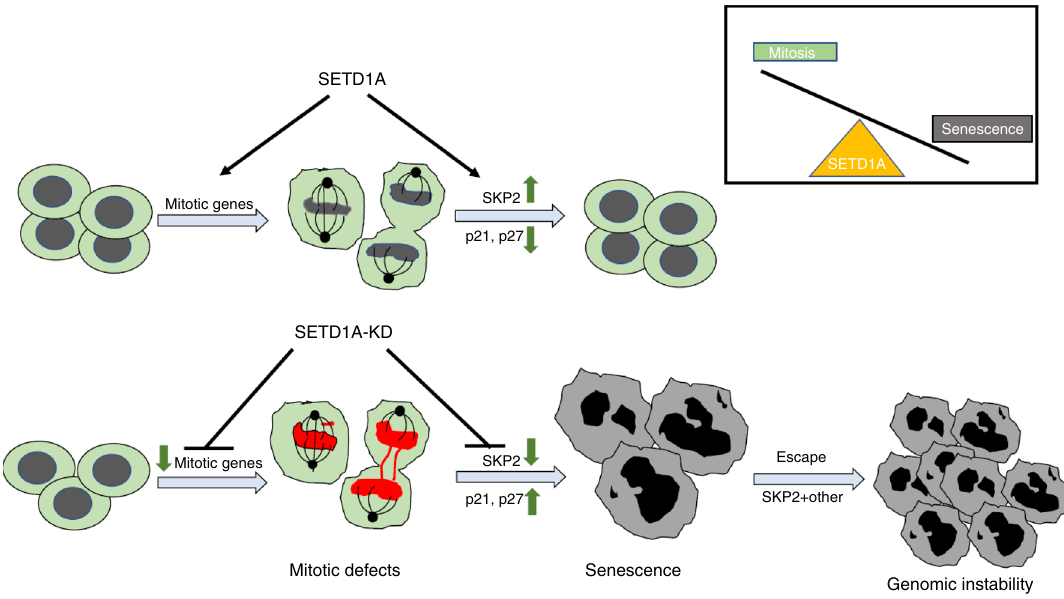
Fig. 7 SETD1A maintains the balance between proliferation and senescence. Suppression of SETD1A leads to mitotic defects and simultaneous repression of SKP2 in these cells causes the defective daughter cells to enter senescence with increased levels of p21 and p27. SETD1A-KD cells escaping senescence re-enter the cell cycle through upregulation of SKP2 as well as other mechanisms. The inset summarizes the pivotal role SETD1A expression in maintaining the balance between mitosis and senescence Table 1 List of target sequences against shRNAs